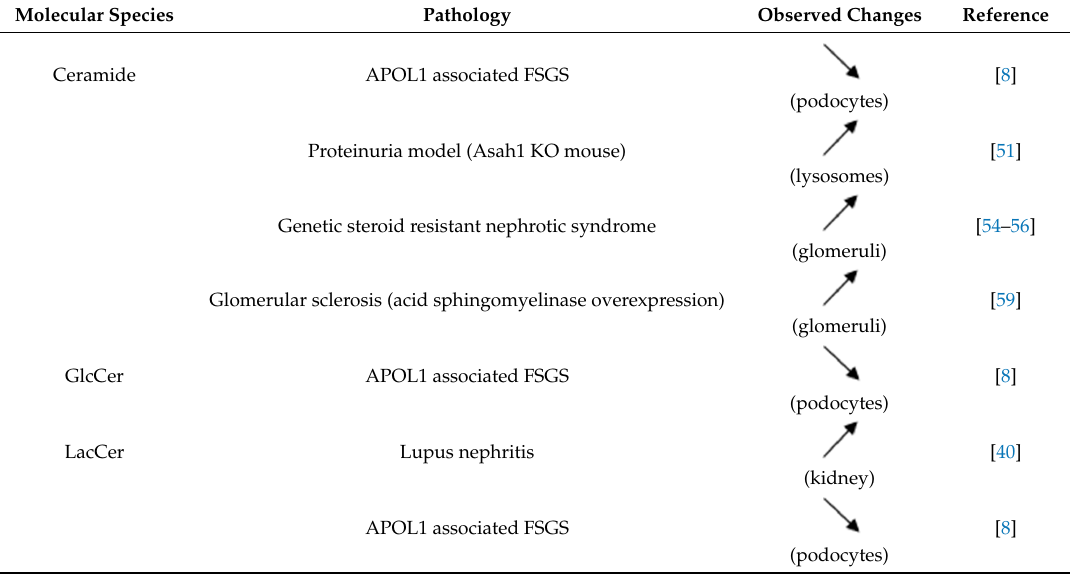
Table 1. Changes in the abundance of gangliosides and precursors associated with glomerular diseases. Molecular Species